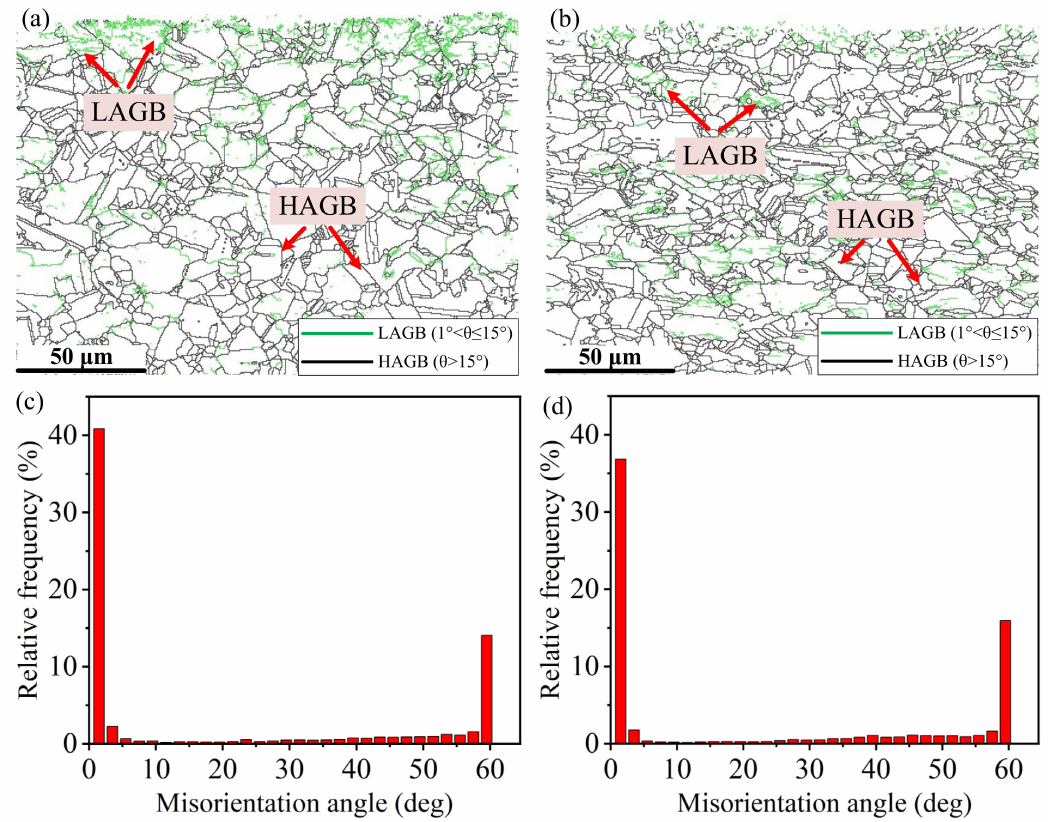
Figure 7. LAGBs and HAGBs distribution after: ( a , c ) the FT process; ( b , d ) the LPB process. However, it should be noted that there is a decrease in the fraction of LAGBs from 54.9 to 47.5% after the LPB process compared with the FT process, as shown in Figure 8. This phenomenon indicates that a certain number of LAGBs had been rotated during LPB, which evolved into HAGBs ( θ > 15 ◦ ). Chamanfar et al. [32] reported that the plastic deformation generated by SP would rotate the grain along the slip system, hence leading to the formation of HAGBs. Chen et al. [33] also proposed that the mutual rotation of grains and the grain boundaries slip induced the HAGBs. There are two main ways for the formation of HAGBs. One is induced by the microstructural evolution. The other is from the evolution of the texture during deformation. The increase in the boundary misorientation angle between adjacent grains is realized by more dislocation accumulation and annihilation at the grain boundaries, the mutual rotation of the grains, the grain boundaries slip and so on.